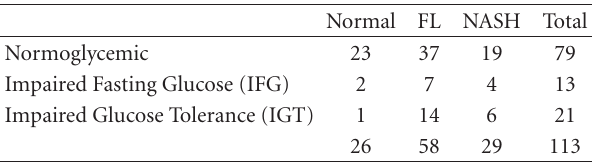
Table 3: Metabolic status of population from 2 hours oral glucose load testing.